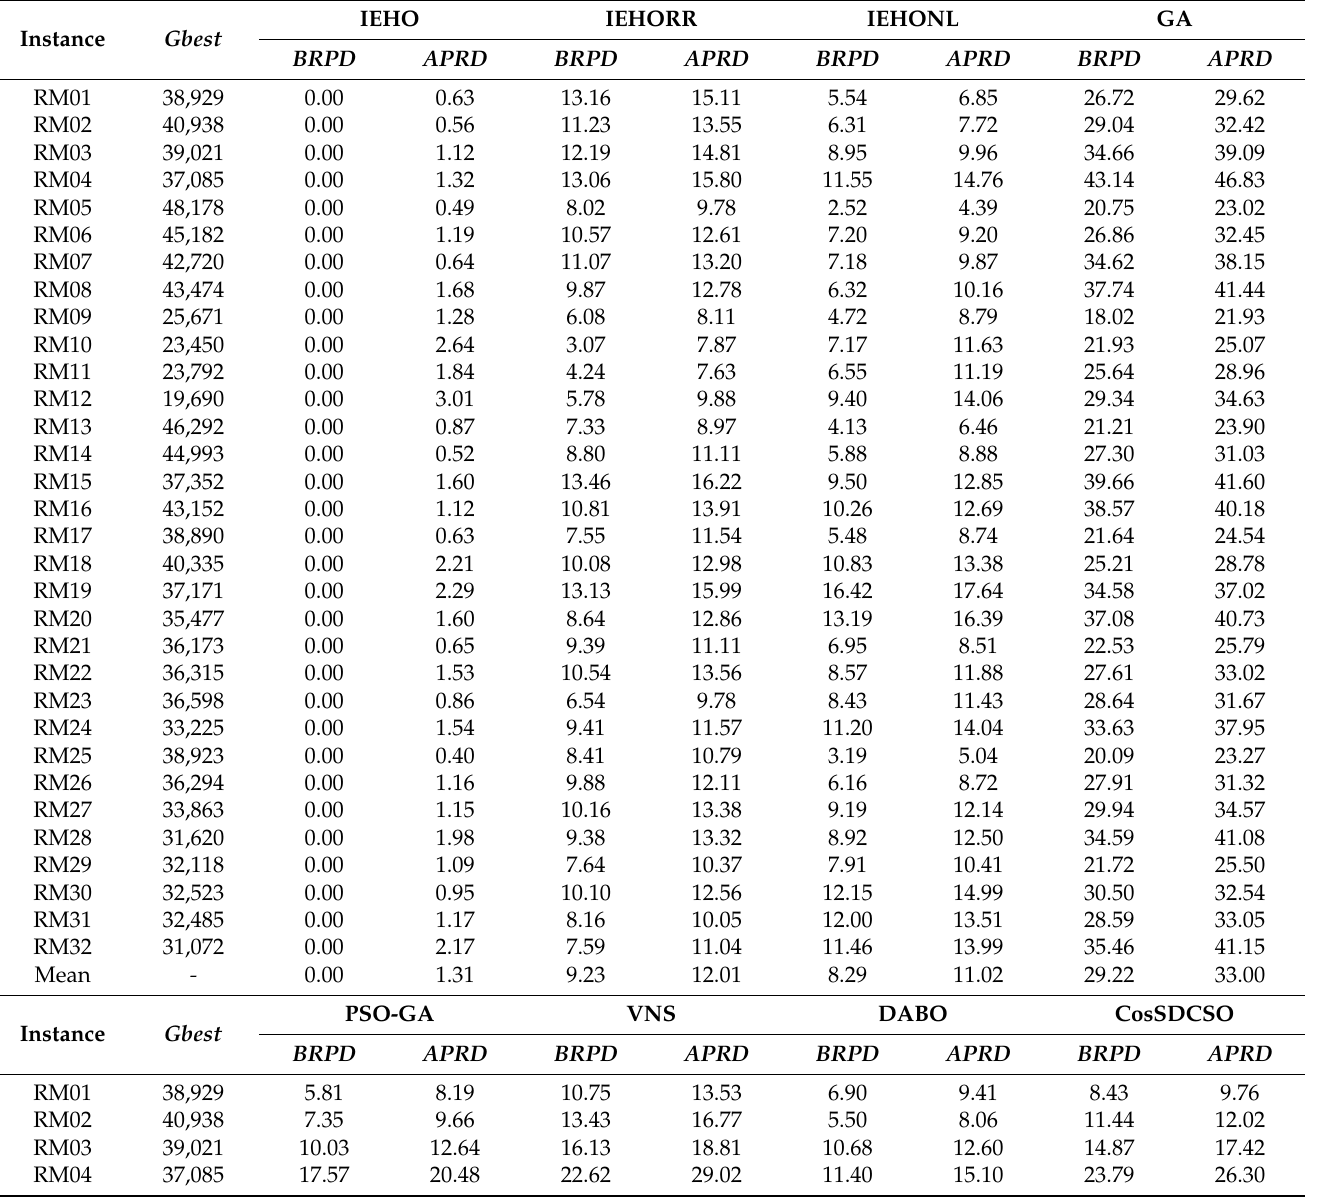
Table 9. Comparison results of the values of